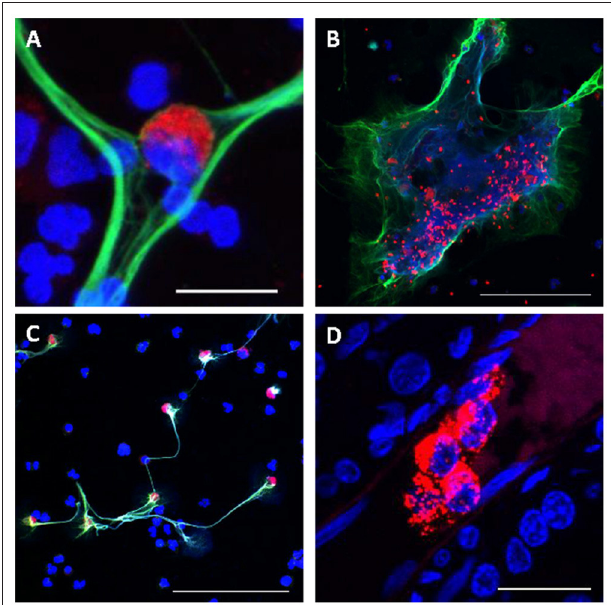
FIGURE 4 | Consequences of Excessive NETosis in SIV-infected nonhuman primates. (A) Monocyte (red) trapped in a NET (green). (B) Trapping of aggregated platelets (red) in a NET (green). (C) Increased expression of TF (red) on polymononuclear neutrophils forming NETs (green), while others polymononuclear neutrophils do not express TF. (D) Occlusion of small blood vessels by NETs (red) in the kidney of a SIV-infected PTM. Nuclear staining was performed with DAPI (blue) for all figures. Scale bar lengths: 20 µ m (A,D) , 100 µ m (B,C) . NET, neutrophil extracellular trap; PTM, pig-tailed macaque; TF: Tissue factor. Reproduced with authorization from Sivanandham et al.